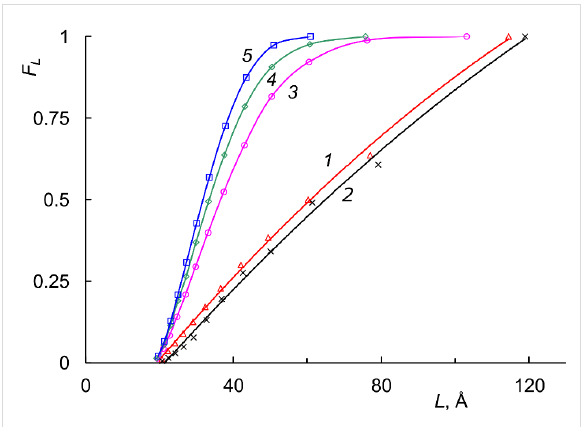
Figure 8: Integral distribution functions for the lamella thickness of crystallites in thermally fractionated (1) PCOE after Gr1 treatment, (2) PCOE/PNB blend, and NB–COE copolymers with different COE- block lengths, (3) L COE = 22, (4) L COE = 12, and (5) L COE = 9.4